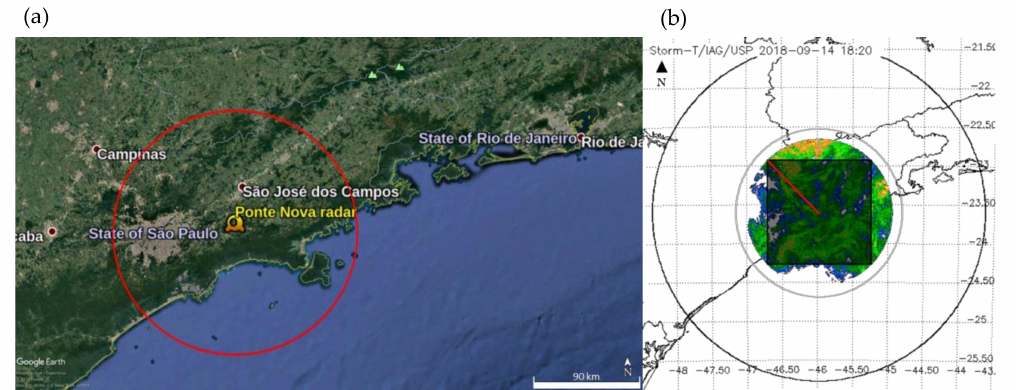
Figure 1. ( a ) Location of the weather radar. The red circle marks 100-km of range; ( b ) Reflectivity image from the Plan Position Indicator (PPI) radar at 0.5 ◦ , with a map of the surrounding area in the background. The red line marks the radius of 100 km and the darker-colored square defines the